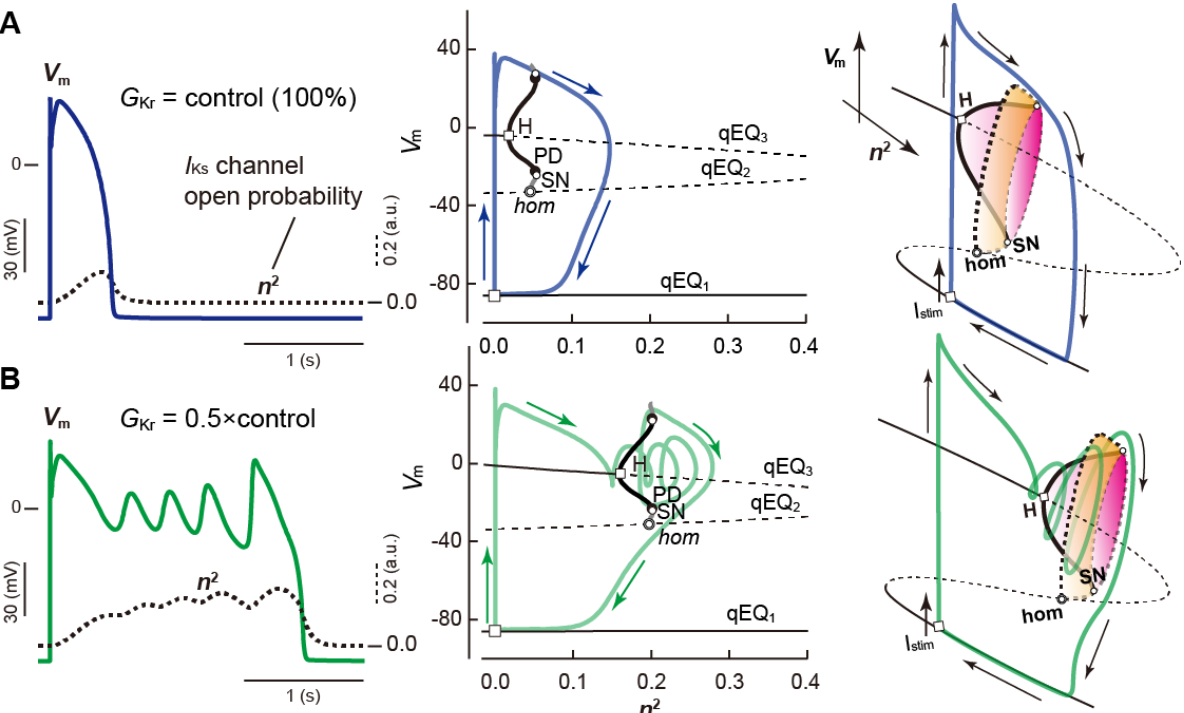
Figure 11. Examples of the slow–fast decomposition analysis. AP simulations and slow–fast decom- position analyses were performed using the Kurata model [112] with G Kr = 100% ( A ) and G Kr = 0.5 × control ( B ). ( Left ) The membrane potential ( V m ) and the time course of I Ks open probability ( n 2 ) in the full system. ( Center ) One-parameter bifurcation diagrams of the fast subsystem, depicting quasi- equilibrium potentials (qEQ 1–3 ) and the potential extrema of quasi limit cycles (qLCs) as a function of the slow variable n 2 . The trajectory of the full system projected onto the ( V m , n 2 )-plane is superim- posed on the one-parameter bifurcation diagram of the fast subsystem. Solid and dashed thin lines of qEQ 1–3 indicate stable and unstable equilibrium potentials, respectively. The black and gray thick lines are stable and unstable qLCs, respectively. H: Hopf bifurcation; SN: saddle-node bifurcation of limit cycles; PD: period-doubling bifurcation of limit cycles; hom: homoclinic bifurcation. ( Right ) Schematic diagrams representing the relationships between the dynamic behavior projected onto the 3-dimensional state space of the full system and the bifurcation structure of the fast subsystem. Modified from [197].